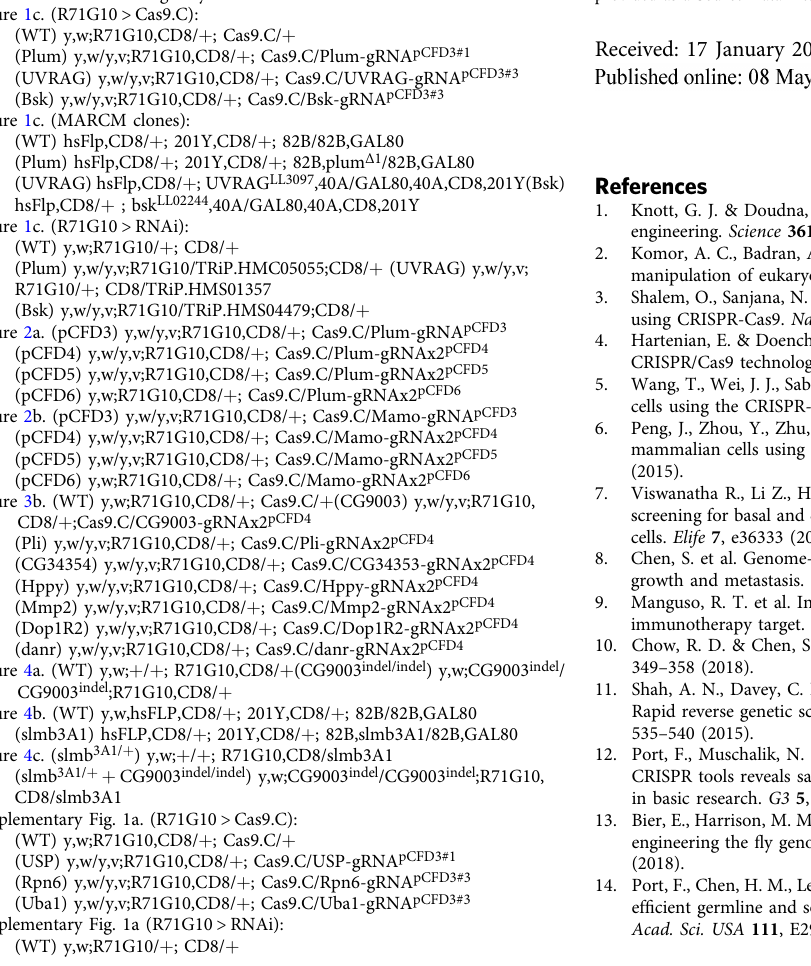
Figure 2b. (pCFD3) y,w/y,v;R71G10,CD8/ + ; Cas9.C/Mamo-gRNA pCFD3 (pCFD4) y,w/y,v;R71G10,CD8/ + ; Cas9.C/Mamo-gRNAx2 pCFD4